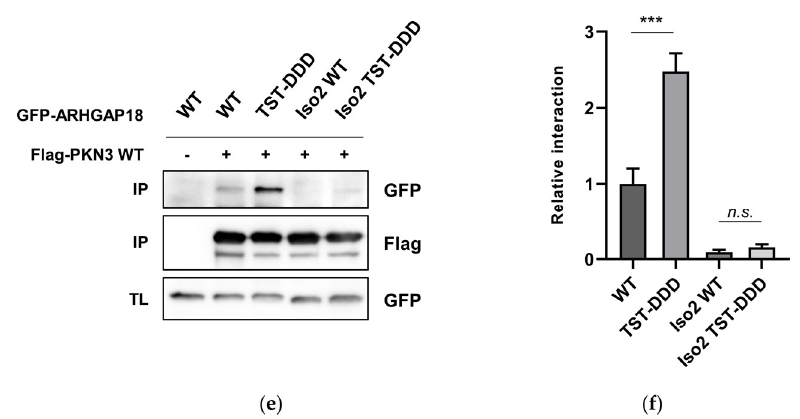
Figure 4. Differential effects of ARHGAP18 isoforms. ( a ) GFP-ARHGAP18 WT and Iso2 (isoform 2) WT were immunoprecipitated with Flag-PKN3 using Anti-Flag Affinity Gel. Samples were subjected to SDS-PAGE and immunoblotted with the respective antibodies. ( b ) An in vitro kinase reaction of WT and unphosphorylatable (TST-AAA) variants of both GFP-ARHGAP18 isoforms in the presence of StrepII-PKN3 and ATPγS. Thiophosphorylated substrates were treated with PNBM and immunoblotted using anti-thiophosphate ester antibody. Reactions with ATPγS or PNBM only were used as specificity controls. ( c,e ) Individual variants of GFP-ARHGAP18 were immunoprecipitated with Flag-PKN3. Samples were subjected to SDS-PAGE and immunoblotted using respective antibodies. ( d,f ) Quantification of three independent immunoprecipitation experiments is shown. Statistical analysis was performed using ANOVA with ( d ) Dunnett′s or ( f ) Tukey′s multiple comparison test: *** p ≤ 0.001; n.s. – not significant. IP – immunoprecipitation; TL – total lysate.